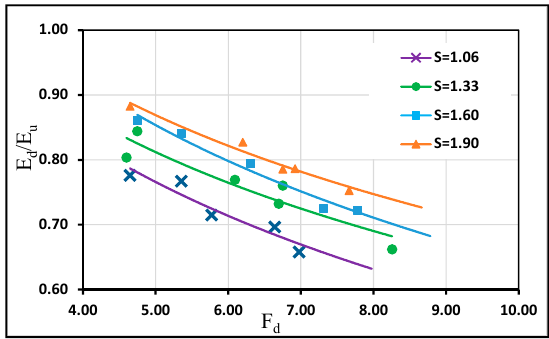
Figure 7. Culvert efficiency for different S. Figure 7. Culvert e ffi ciency for di ff erent